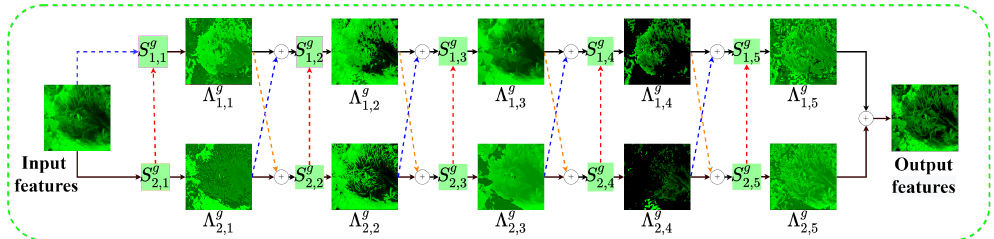
Figure 5. An extract of the detailed illustration of the dual-path block and the parallel interaction function for the green color channels’ RCNN from Figure